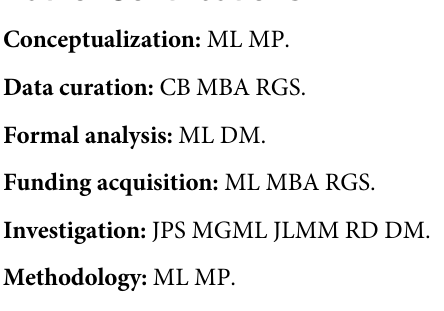
S1 Fig. Melting curve dissociation analysis of Bifidobacterium longum (A) and Roseburia hominis (B). S2 Fig. Observed species, Chao1, and phylogenetic distance whole tree rarefaction curves. Plotted red line is the mean±standard deviation of active women samples and blue line is the mean±standard deviation of sedentary women samples. S1 Table. Primers and amplification conditions for real-time